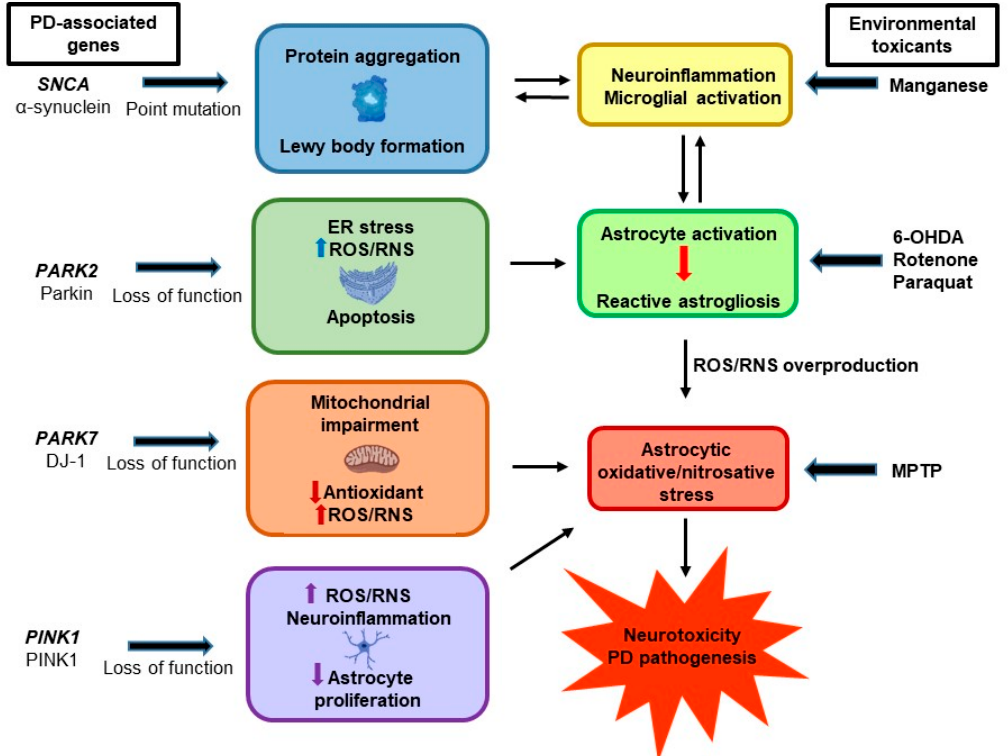
Figure 2. Gene–environment interactions contributing to astrocytic oxidative and nitrosative stress and Parkinson’s disease (PD) pathogenesis. Aberrant functions of PD-associated genes, such as SNCA, PARK2, PARK7, and PINK1, induce astrocytic oxidative/nitrosative stress. In addition, exposure to environmental factors such as 1-methyl-4-phenyl-1,2,3,6-tetrahydropyridine (MPTP), 6-hydroxydopamine (6-OHDA), rotenone, manganese, and paraquat, are also associated with astrocytic oxidative / nitrosative stress and